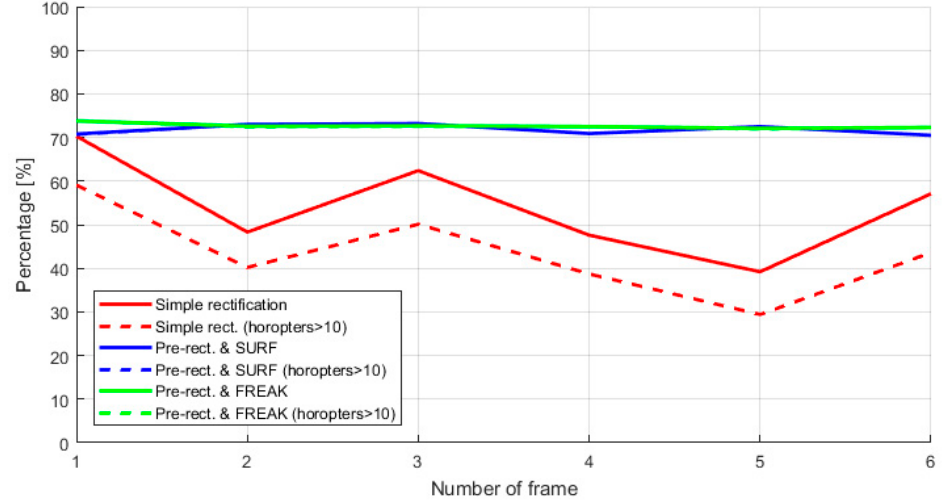
Figure 2. Chart showing the percentage of effective stereo frame used to calculate the Disparity Map (DM) during the first six neighboring frames (consecutive frames) of the 1 s pre-crash sequence. Below 45%, the number of reliable pixels is insufficient to compute the DM. The corresponding DMs for these six frames are presented in the Appendix C.